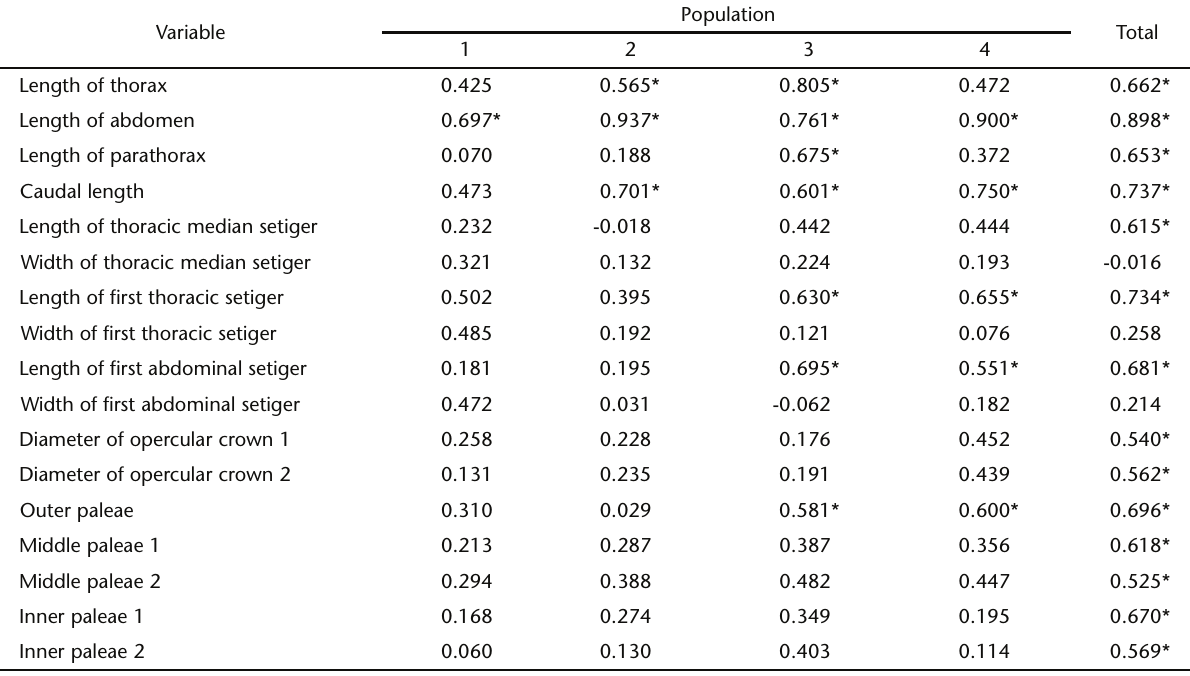
Table II. Pearson’s correlation coefficient of the variables calculated for each population of P. caudata . (*) Significant values at p >